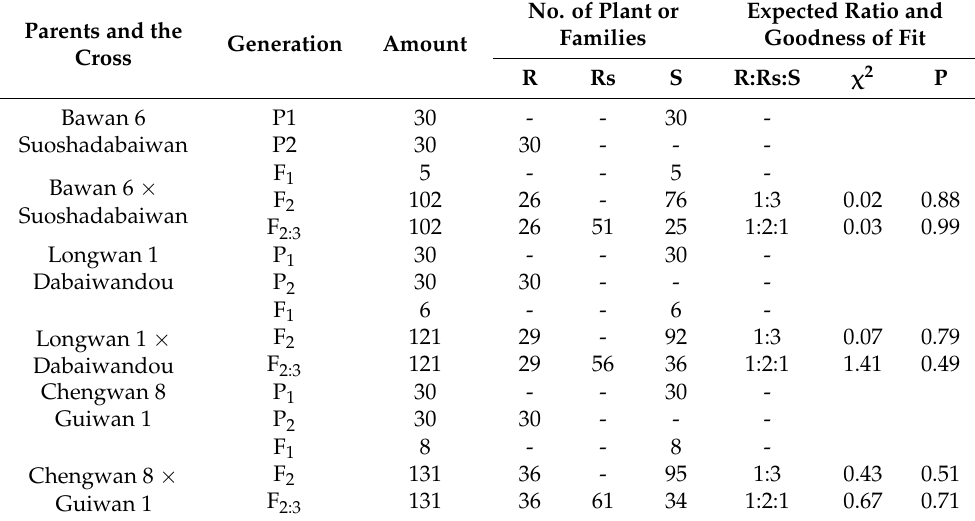
Figure 1. Phenotypic evaluation of the three Erysiphe pisi -resistant pea cultivars Suoshadabaiwan, Dabaiwandou, and Guiwan 1, as well as the three E. pisi -susceptible cultivars Bawan 6, Longwan 1, and Chengwan 8, after inoculation with E. pisi isolate EPYN. ( A ) Suoshadabaiwan and E. pisi - susceptible cultivar Bawan 6 (BW6). ( B ) Dabaiwandou and E. pisi -susceptible cultivar Longwan 1. ( C ) Guiwan 1 and E. pisi -susceptible cultivar Chengwan 8. Table 1. Segregation patterns of pea resistance to powdery mildew in the F 1 , F 2 , and F 2:3 pop- ulations derived from three crosses, Bawan 6 × Suoshadabaiwan, Longwan 1 × Dabaiwandou, Chengwan 8 × Guiwan